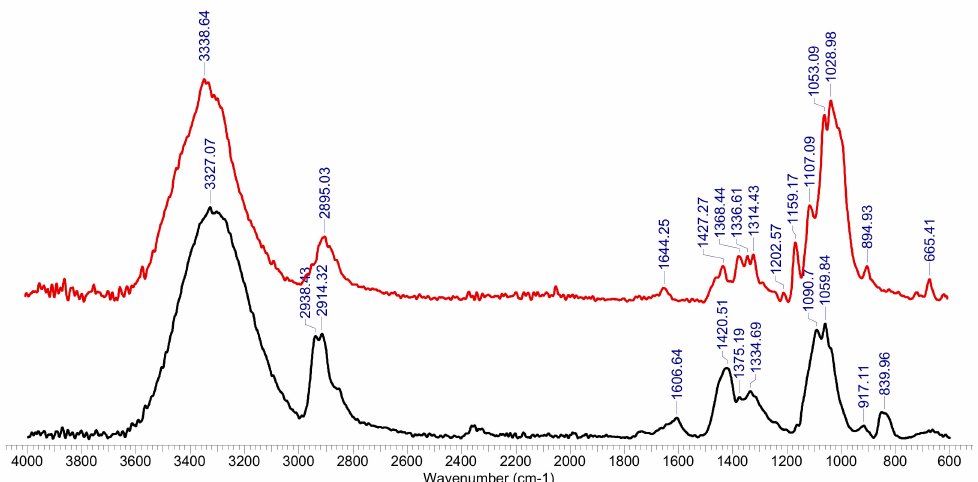
Figure 2. FTIR spectrum for OxC25 hydrogel before (line black) and after Co 2+ species adsorption (red